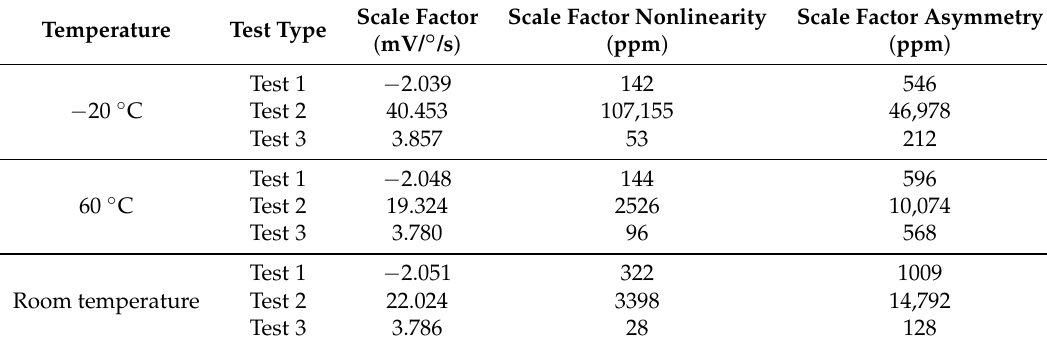
Figure 15. The residual errors of the scale factor under different temperatures: ( a ) − 20 ◦ C condition, ( b ) Room temperature condition, ( c ) 60 ◦ C condition. Table 2. Scale factor performance of the tested gyroscope.